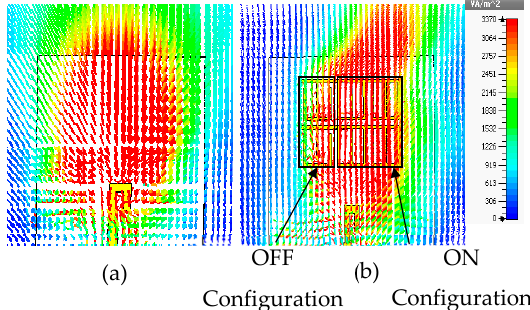
Figure 14. Radiation power flow in E-plane at 28 GHz: ( a ) dipole antenna; ( b ) MM antenna.